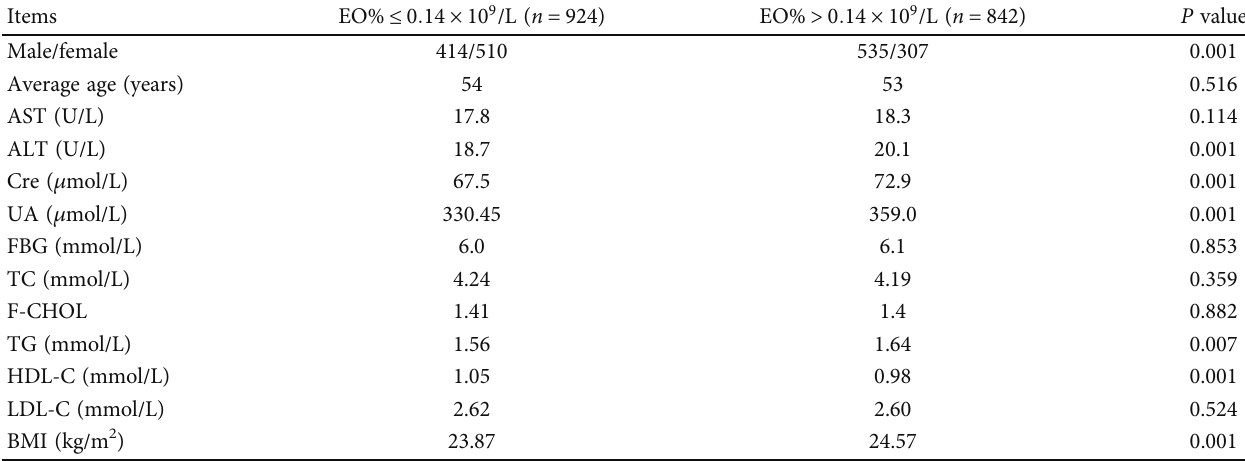
Table 3: Comparison of clinical data of patients in the EO# ≤ 0 : 14 × 10 9 /L and EO#>0 : 14 × 10 9 /L groups.